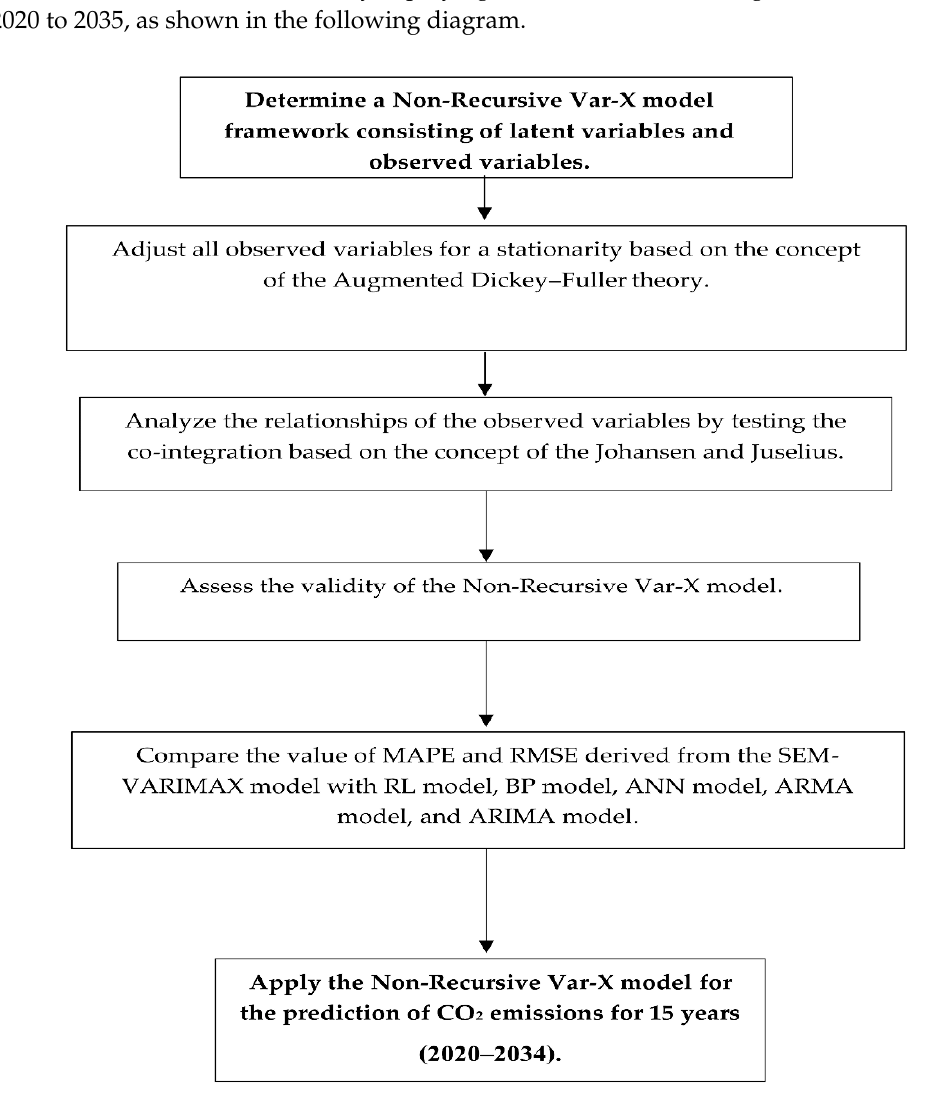
Figure 1. The flowchart of the Second Order Autoregressive -SEM.